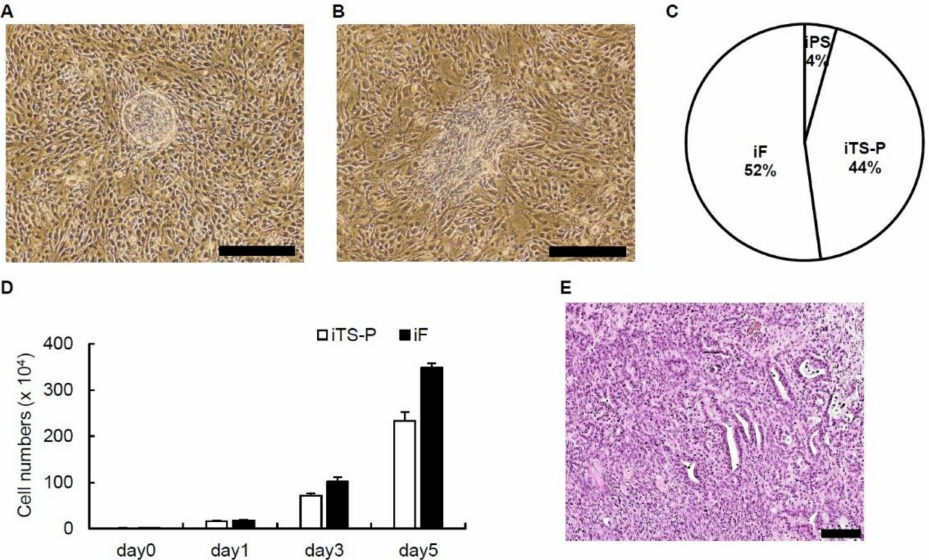
Figure 1. Generation of mouse induced tissue-specific stem (iTS) cells and induced fibroblast-like (iF) cells. ( A ) The morphology of mouse iTS-P cells. Scale bars = 500 µ m. ( B ) The morphology of mouse iF cells. Scale bars = 500 µ m. ( C ) Percentages of iPS, iTS-P, and iF cells forming colonies. The OSKM plasmid vector was transfected into mouse pancreatic tissue, and colonies were counted after 30–45 days. n = 5. ( D ) Proliferation of iTS-P cells and iF cells. ( E ) Hematoxylin and eosin staining of tumors derived from iF cells. Scale bar = 100 µ